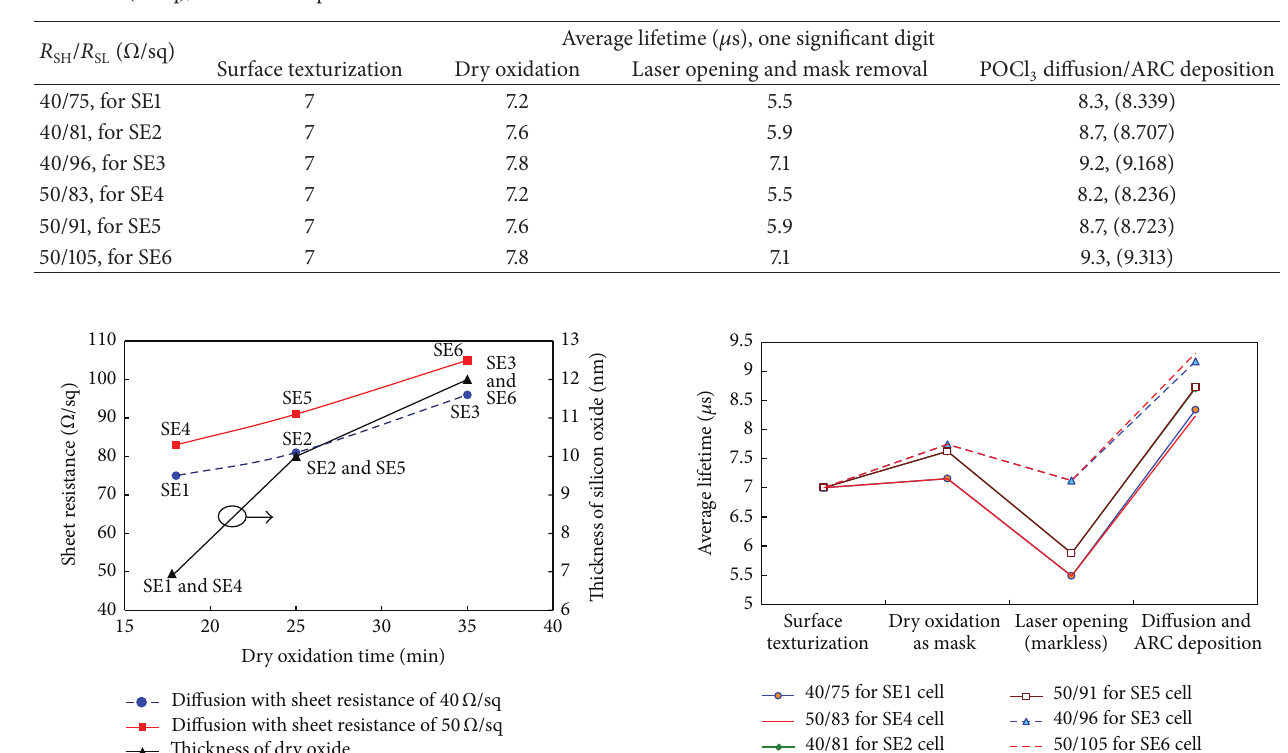
is lightly doped sheet SL